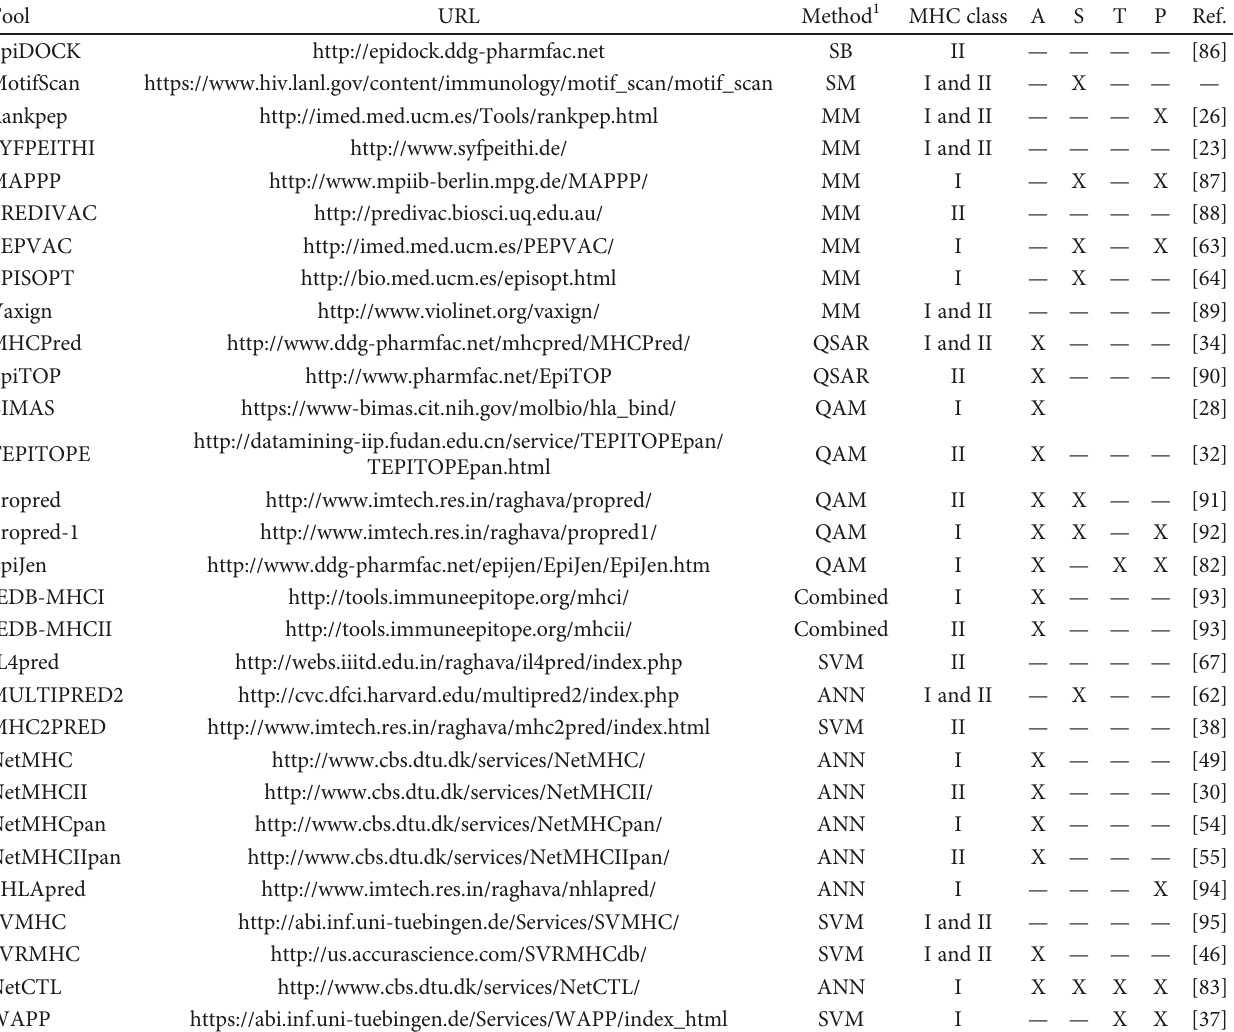
1 Method used for prediction of peptide-MHC binding. Keys for methods: SM: sequence motif; SB: structure-based; MM: motif matrix; QAM: quantitative a ffi nity matrix; SVM: support vector machine; ANN: arti fi cial neural network; QSAR: quantitative structure-activity relationship model; combined: tool uses di ff erent methods including ANN and QAM, selecting the more appropriate method for each distinct MHC molecule. The table also indicates whether the tools predict quantitative binding a ffi nity (A), supertypes (S), TAP binding (T), and proteasomal cleavage (P); marked with an X in the a ffi rmative